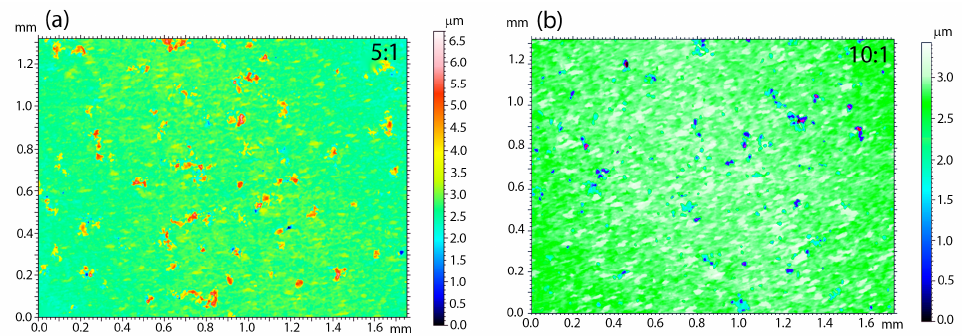
Figure 7. 3D topography of surface layers 10:1 ( a ) and 5:1 ( b